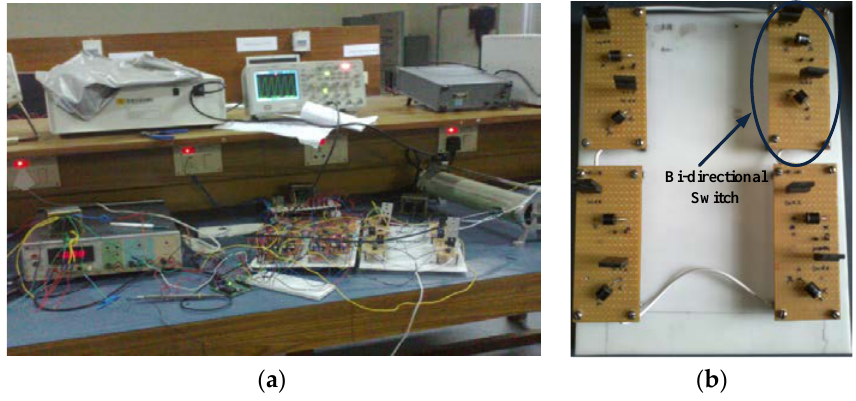
Figure 13. Experimental setup of ( a ) SPMC and its ( b ) bi-directional switch.